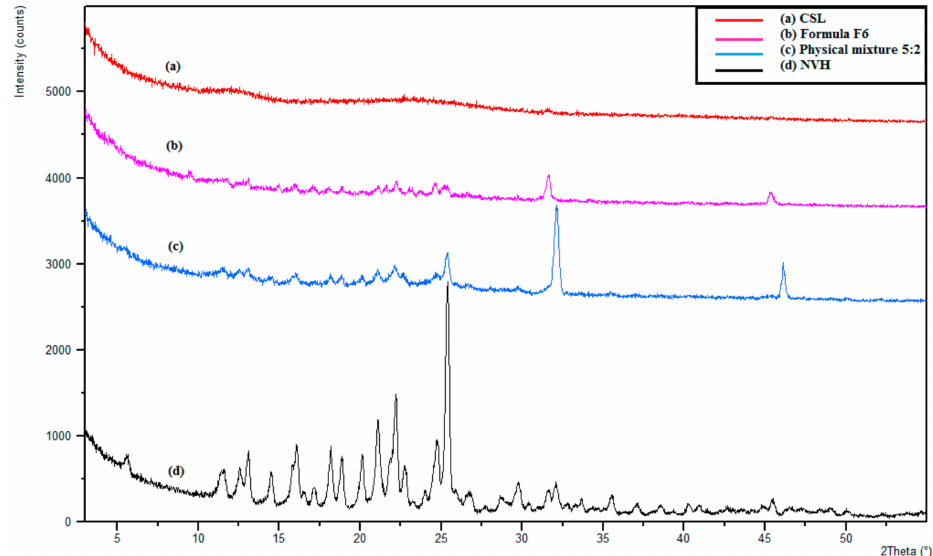
Figure 5. X-ray diffractogram of ( a ) CSL; ( b ) lyophilized optimal chitosomal formulation F6; ( c ) phys- ical mixture (5:2) of CSL and NVH; ( d )